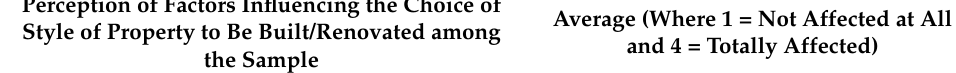
Table 2. Perception of importance of factors influencing style choice (average, where 1 = not at all, 4 = totally